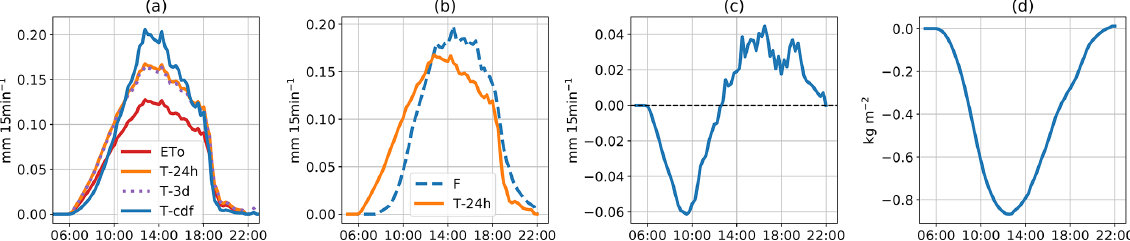
Figure 5. A four-step procedure to reconstruct the diurnal variation in VWC. An example for 25 July 2019. Panel (a) shows the diurnal cycles of reference evapotranspiration (ET 0 ) and the three transpiration estimates (see Table 1). Panel (b) shows the diurnal cycles of sap flow ( F ) and one of the transpiration estimates (T-24h). Panel (c) is the difference between sap flow and transpiration, where negative values indicate depletion of water storage, and positive values indicate refill. Panel (d) illustrates the resulting cumulative change in stored water ( (cid:49) VWC) during the